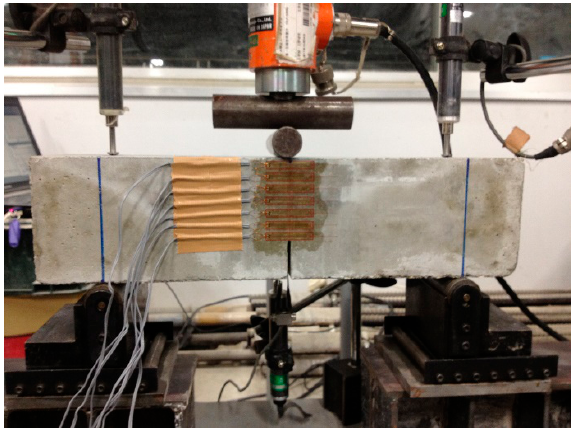
Figure 4. Seven strain gauges for investigation of the vertical strain distribution.